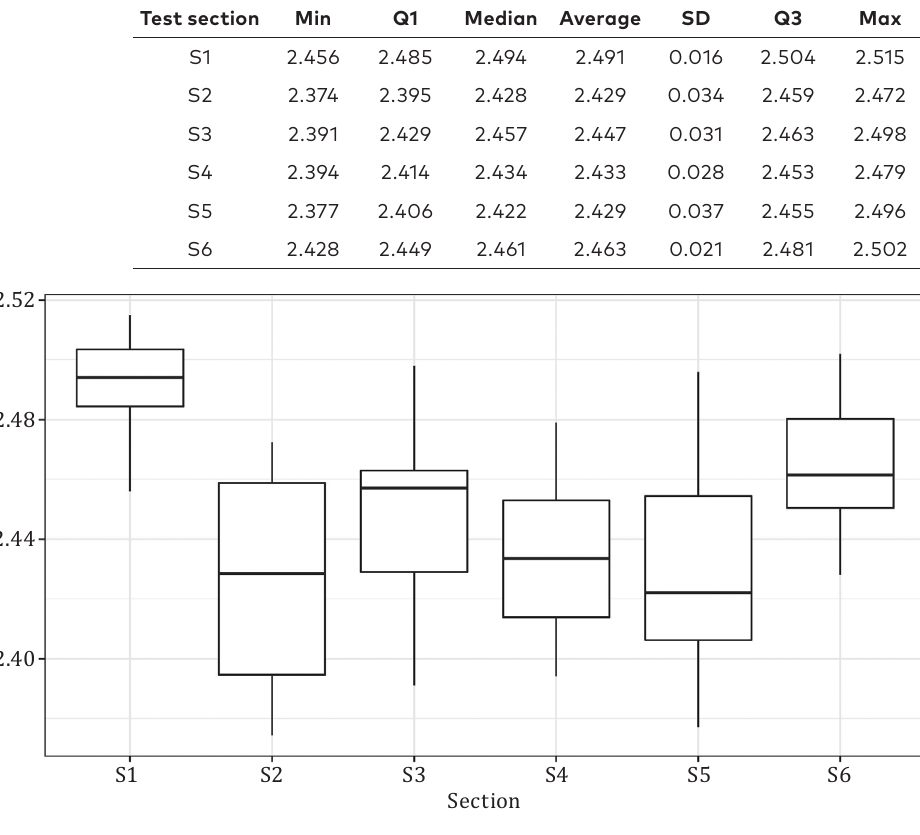
Figure 6. Box-plot diagram of the Core D